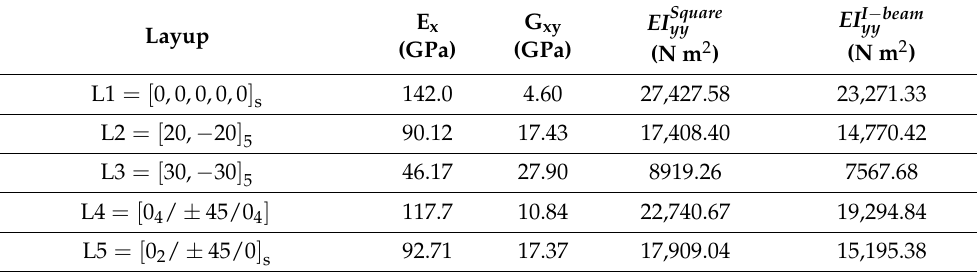
Table 2. Mechanical properties for CFRP and AA beams with square and I-shaped cross-sections. Layup